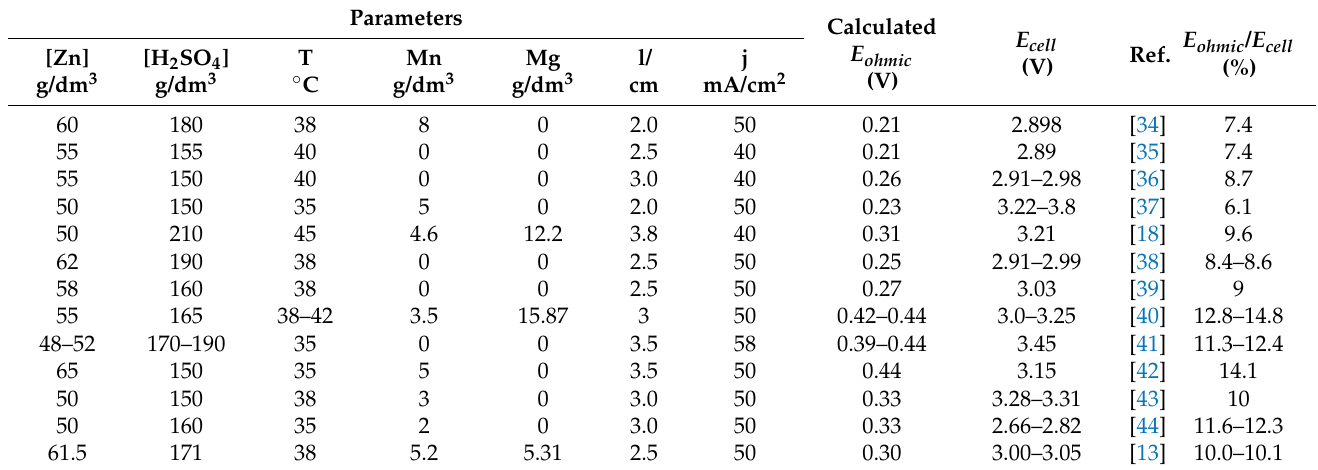
Table 3. Zinc electrowinning operating conditions and calculated E ohmic